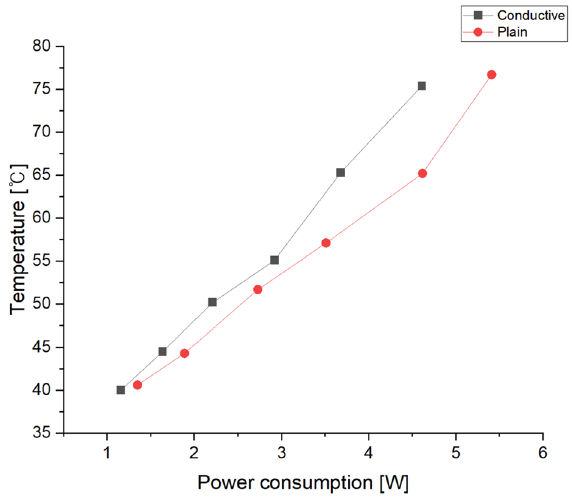
Fig. 6 Temperature dependence on the power consumption of plain and conductive fabric samples